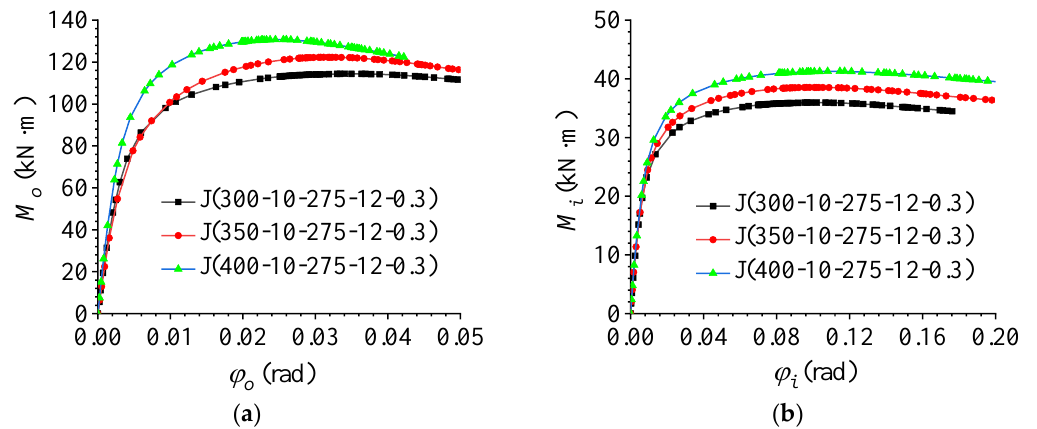
Figure 13. Effect of the member section height. ( a ) Out-of-plane M–φ curve; ( b ) in-plane M–φ curve.